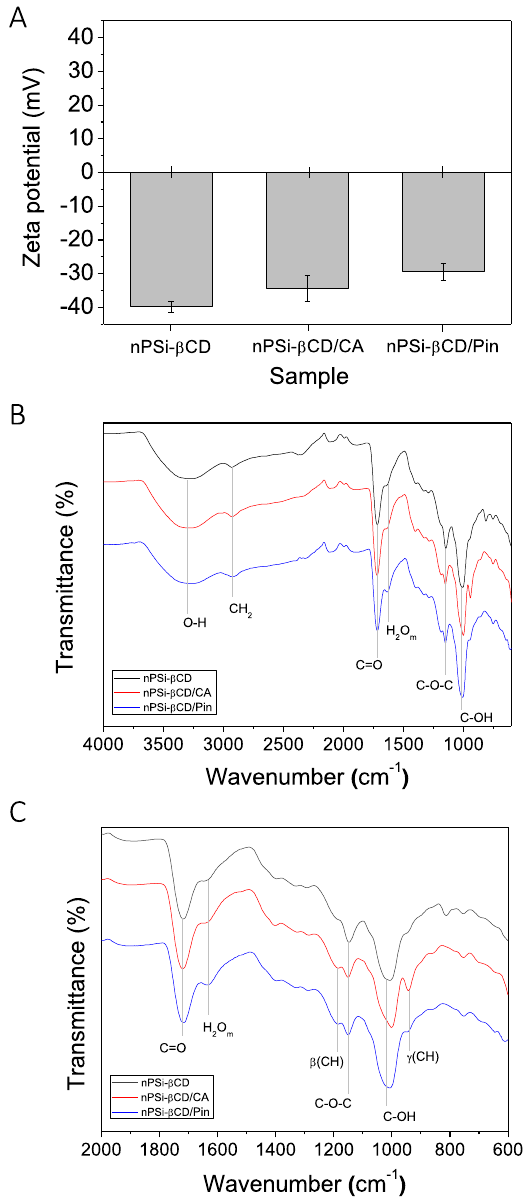
Figure 4. Monitoring of the polyphenols loading on PSi- β CD composite microparticles via: ( A ) Zeta potential and ( B ) Attenuated total reflectance Fourier transform infrared spectroscopy analysis (ATR-FTIR). ( C ) Zoom in of ATR-FTIR spectra.